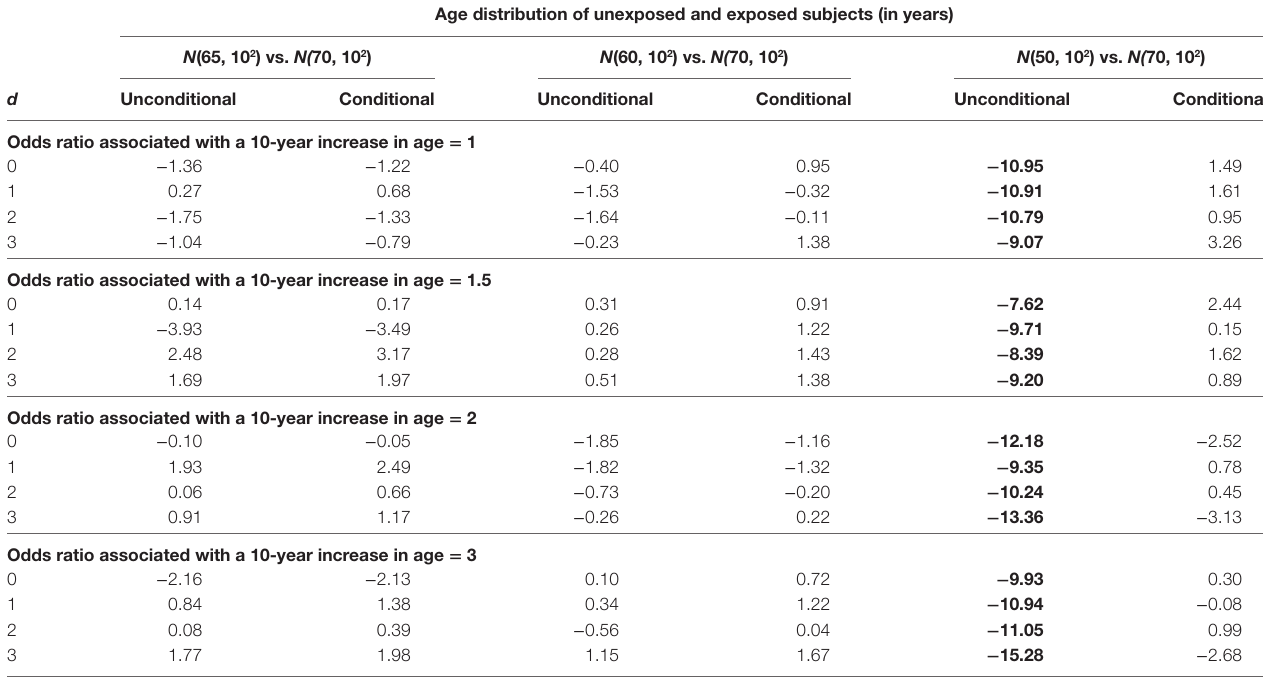
Table 5 | Percents of bias (%) of unconditional and conditional logistic regression models under the alternative